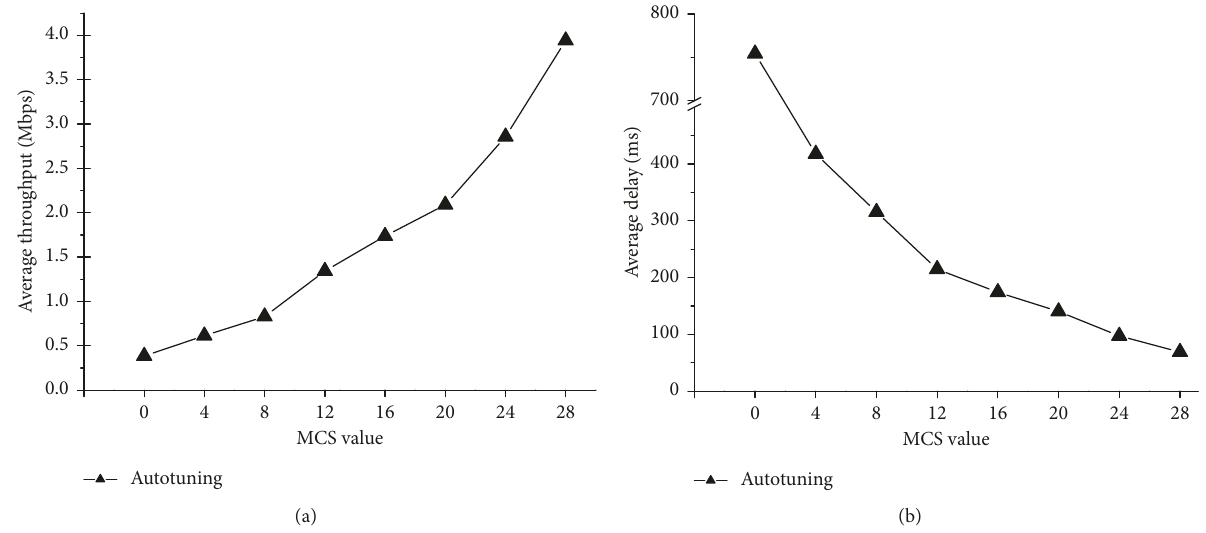
Figure 4: Performance of users with the autotuning method for varying MCS values. (a) Average throughput. (b) Average